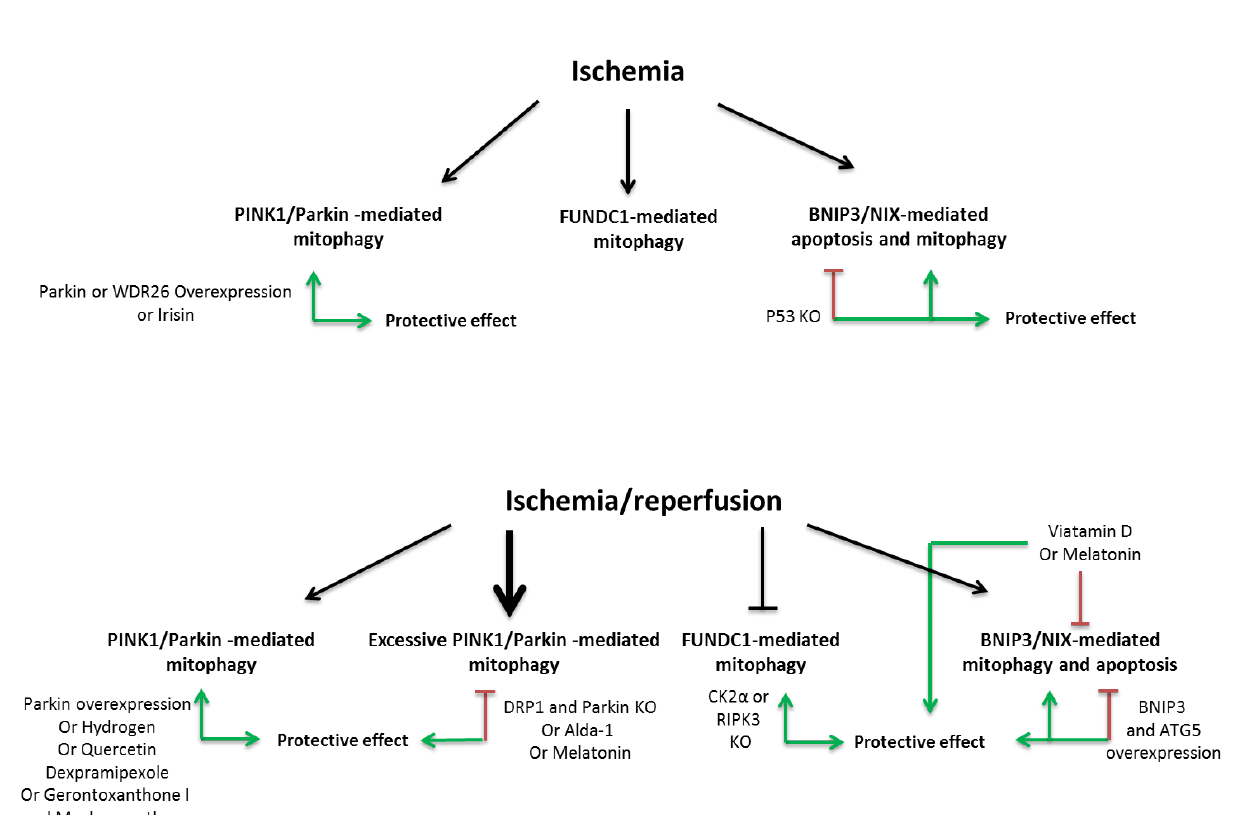
Figure 2. Mitophagy regulation during ischemia and ischemia/reperfusion (I/R). Ischemia induced PINK1/parkin-mediated mitophagy in vivo and in vitro. Moreover, ischemia increases FUNDC1- mediated mitophagy by decreasing its phosphorylation at Tyr-18. BNIP3 is overexpressed during ischemia and is more involved in apoptosis than mitophagy. Several genetics models and pharma- cologic treatments leading to activate mitophagy during ischemia have protective effect by decreasing cells apoptosis. Mitophagy regulation is controversial during I/R; the PINK1/parkin-mediated mitophagy is active during I/R and can be excessive in some cases depending on time of I/R in- ducing cell apoptosis. I/R inhibits FUNDC1-mediated mitophagy by increasing CK2 α and RIPK3 expression, leading an increase in inhibitory phosphorylation of FUNDC1 at Ser-13 and a decrease in its interaction with LC3. The inhibition of excessive PINK1/parkin-mediated mitophagy or the activation of FUNDC1-mediated mitophagy has a protective effect. Finally, I/R induced BNIP3- mediated apoptosis and mitophagy. The overexpression of ATG5 with BNIP3 has a protective effect by increasing mitophagy and cell vitality; however, vitamin D and melatonin have a protective effect by decreasing BNIP3 expression leading to inhibition of BNIP3-mediated mitophagy and apoptosis. PINK1: PTEN-induced putative kinase protein-1, FUNDC1: FUN14